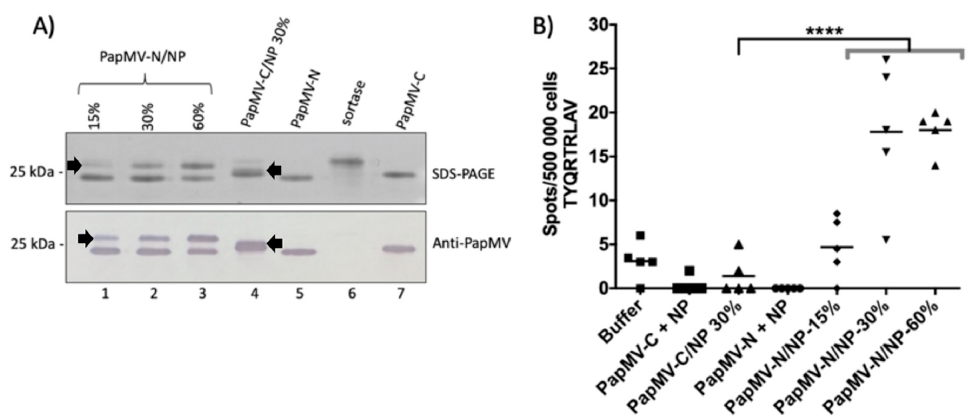
Figure 5. Impact of coupling density of a CTL epitope on the level of CD8+-mediated immune response. ( A ) Visualization of coupling of the nucleocapsid (NP) CTL epitope derived from the nucleocapsid of influenza A virus to PapMV-C and PapMV-N vaccine platforms on SDS-PAGE (top panel). Coupling efficiencies of 15% (lane 1), 30% (lane 2), and 60% (lane 3) on the PapMV-N platform are shown. Coupling of the NP peptide on the PapMV-C platform at 30% is shown in lane 4. The arrowheads pointing to the right indicate the position of PapMV-N coupled to NP peptide, and the black arrowheads pointing to the left indicate the position of PapMV-C coupled to the NP peptide (lane 4). The PapMV-C CP (lane 5), sortase (lane 6), and the PapMV-C CP (lane 7) are also shown. The proteins from SDS-PAGE were transferred to a membrane for Western blotting with anti-PapMV antibodies (lower panel) to confirm the identity of the coupled and uncoupled bands. ( B ) CD8+-mediated immune response directed to the NP CTL epitope coupled on the PapMV vaccine platforms. The influenza CTL epitope (TYQRTRLAV), named NP, was fused to PapMV-C and PapMV-N and injected i.m. in Balb/C mice, five per group, at days 0 and 21. The animals were injected with vaccine formulation buffer, PapMV-C (30 µg) + NP (1 µg), 30 µg of PapMV-C/NP 30%, PapMV-N (30 µg) + NP (2 µg), 30 µg of PapMV-N/NP 15%, 30 µg of PapMV-N/NP 30%, or 30 µg of PapMV-N/NP 60%. At day 35, spleens were harvested and the CD8+-mediated immune response was assessed by ELISPOT using the TYQRTRLAV peptide to stimulate the splenocytes. **** p < 0.0001.